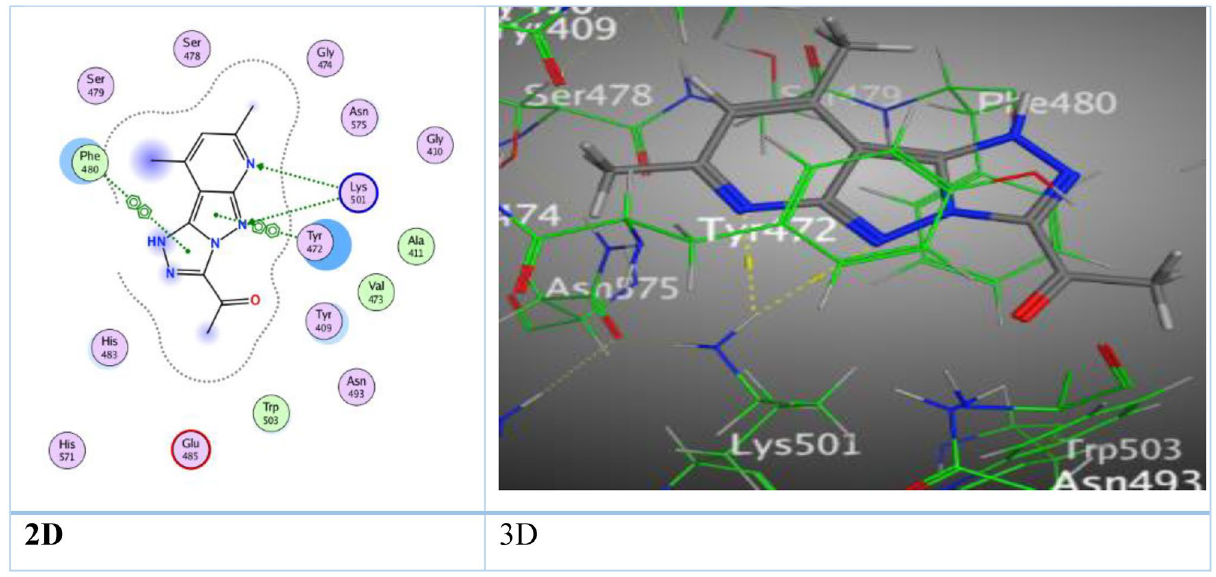
Figure 14. The binding interactions of compound 12 with active sites of (PDB ID: 5IVE).